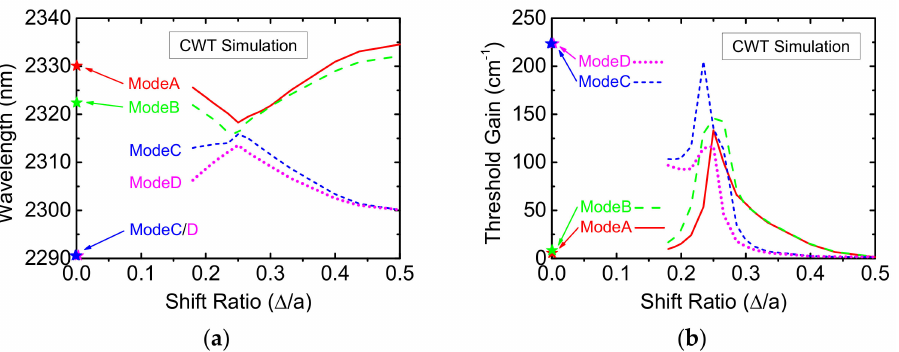
Figure 6. The simulated ( a ) band-edge wavelengths and corresponding ( b ) threshold gains are plotted versus shift ratio based on the CWT model.